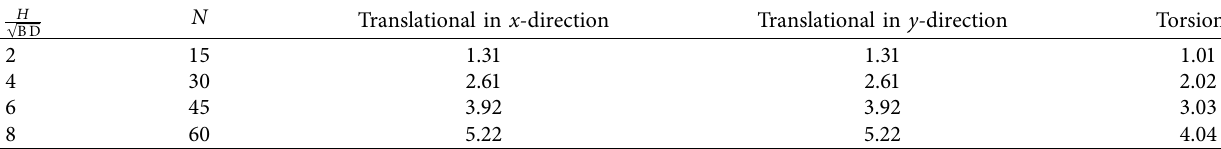
Table 4: First period [s] of the N -story shear building in each direction: D / B � 1.